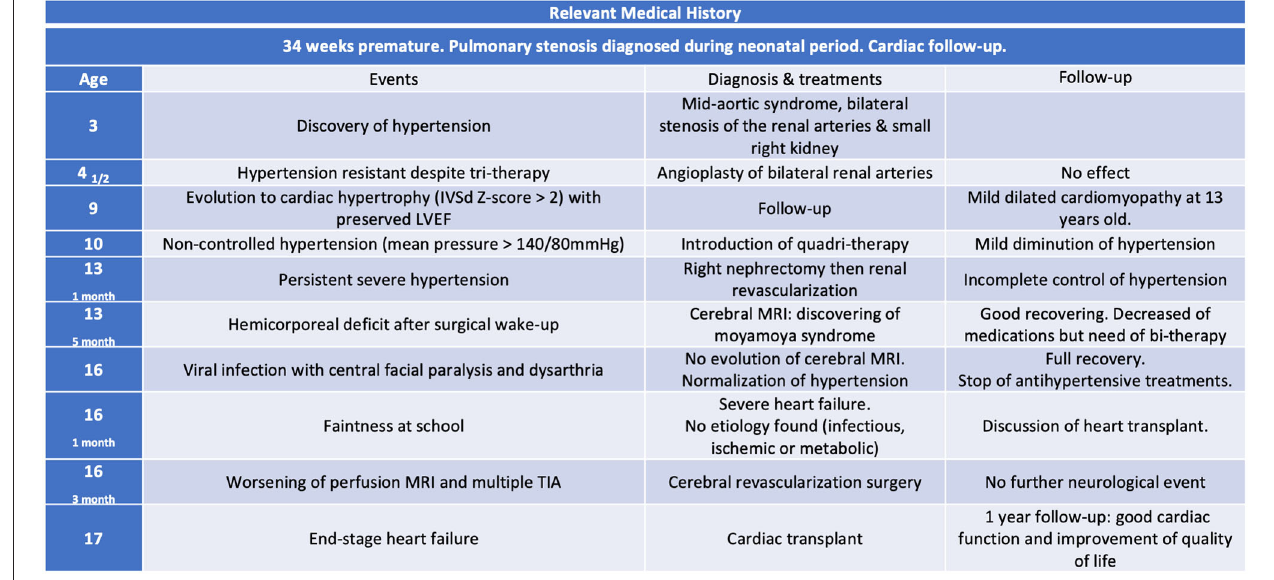
FIGURE 2 | Timeline table, resuming evolution of neurological and cardiac disease. The patient’s written consent was obtained for